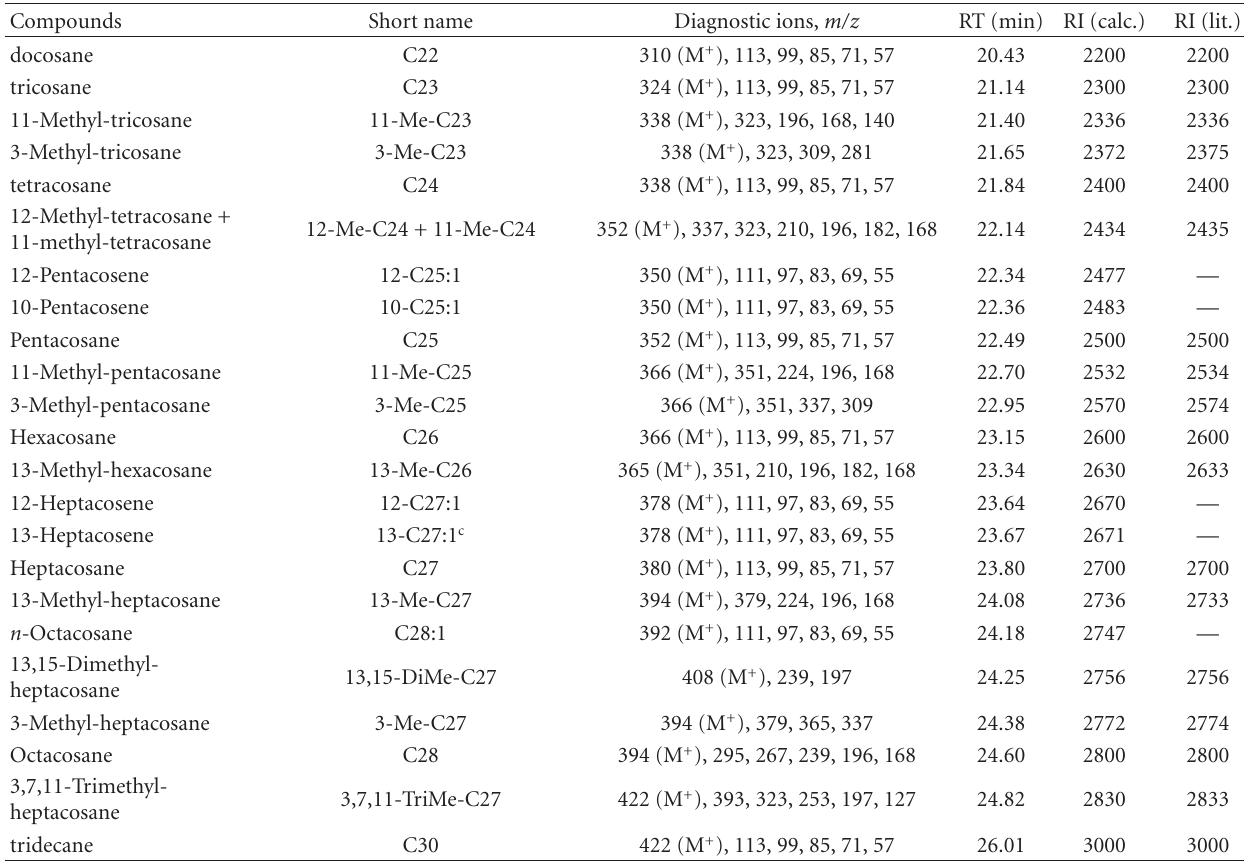
Table 2: Cuticular hydrocarbons from hexane extracts of fire ants Solenopsis saevissima obtained from di ff erent regions of Brazil.